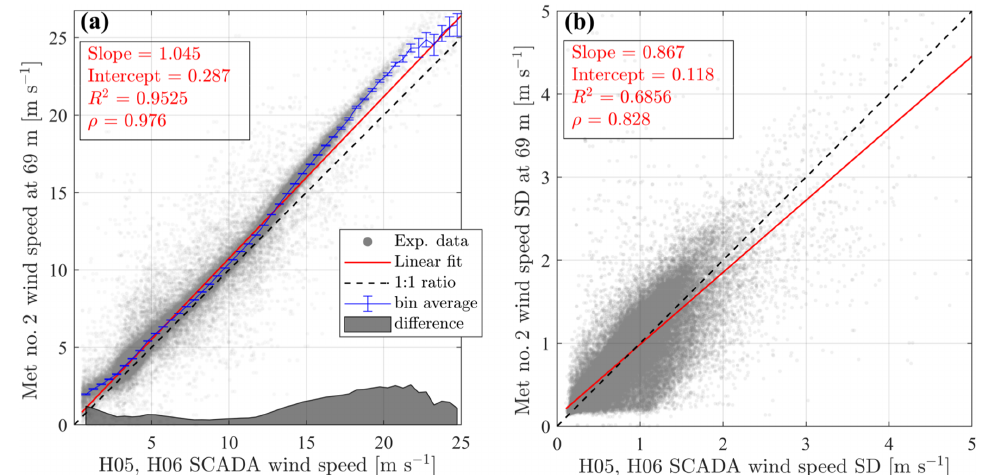
Figure 19. Nacelle transfer function for mean (a) and standard deviation (b) of wind speed. The error bars represent the standard error on the mean with 95% confidence level.